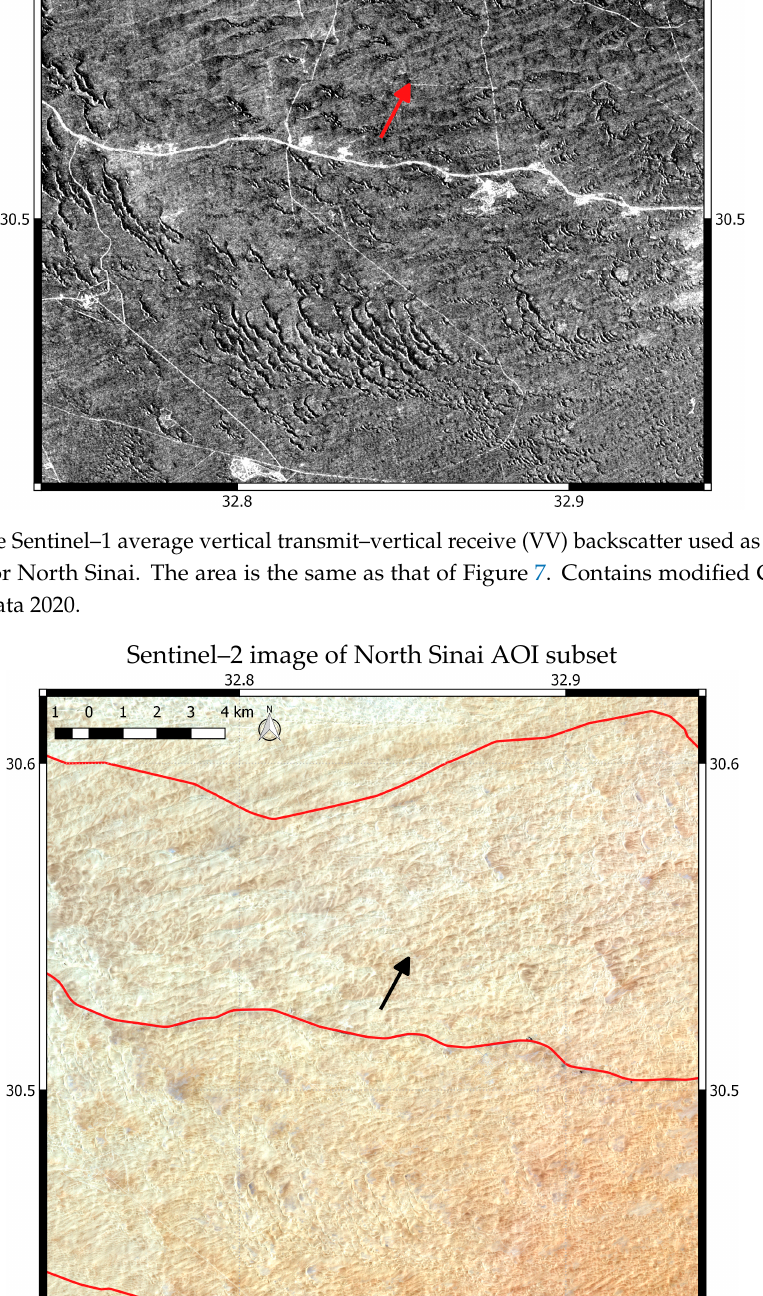
Figure 10. Close–up of the buried road segment shown in the very high resolution (VHR) optical data available on Google Earth Pro. The area corresponds with that shown by the red arrow in Figures 7 – 9. The imagery date is reported to be 5 May 2010.